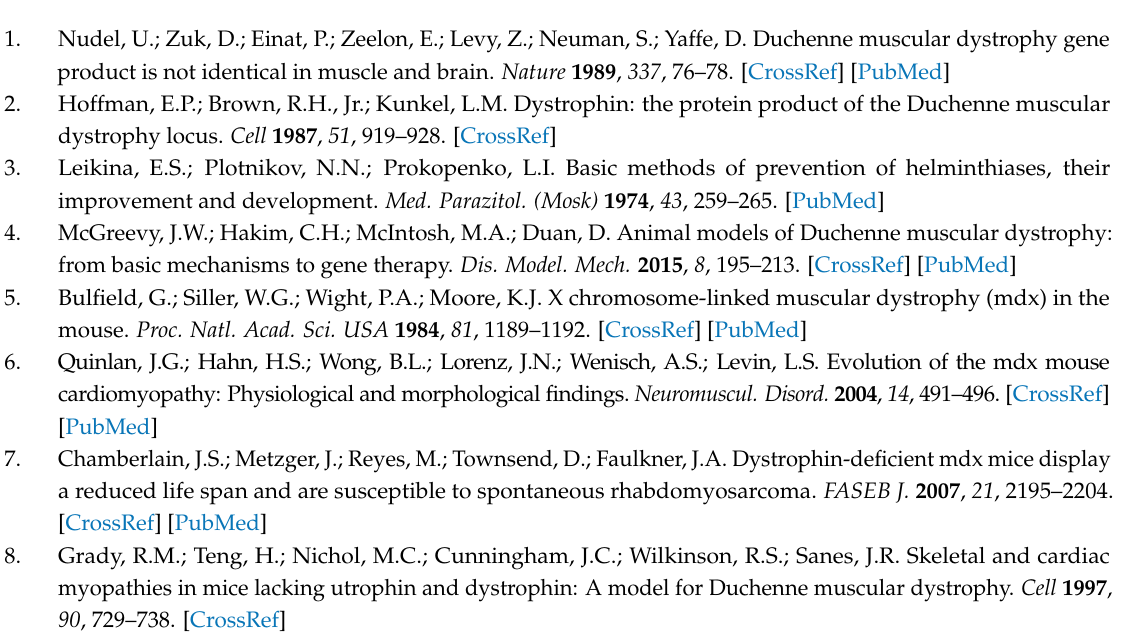
Figure S1: Flow cytometry analysis of SC marker integrin α -7 staining of column-isolated SCs. Figure S2: Metabolic pathways commonly identified in SCs, serum, and APCs. Figure S3: Flow cytometry analysis of APC marker Sca1 staining of column-isolated APCs. Figure S4: A bar graph quantifying the relative abundance of SC carnitine species. Table S1: SC differentially expressed metabolites, Table S2: Serum differentially expressed metabolites, Table S3: APC differentially expressed